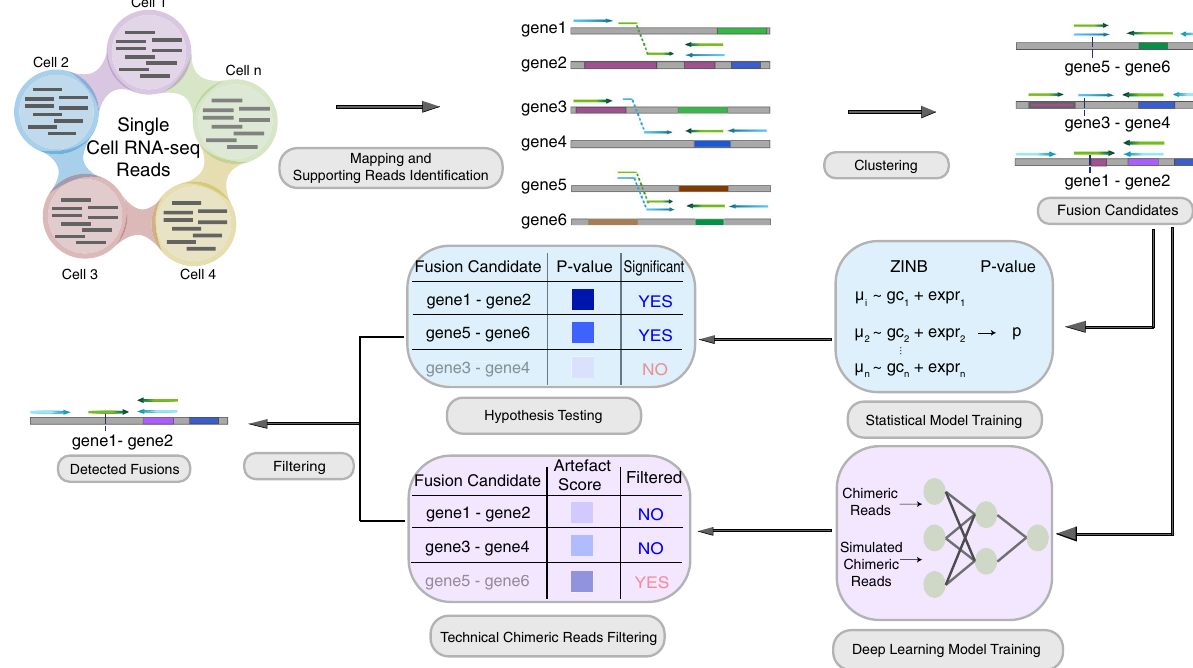
Fig. 1 Overview of scFusion for single-cell gene fusion detection. The single-cell RNA-seq reads are mapped and supporting reads are identi fi ed and clustered to obtain the fusion candidates list. Given the candidate information, a ZINB-based statistical model and a deep-learning model are trained to fi lter the potential false